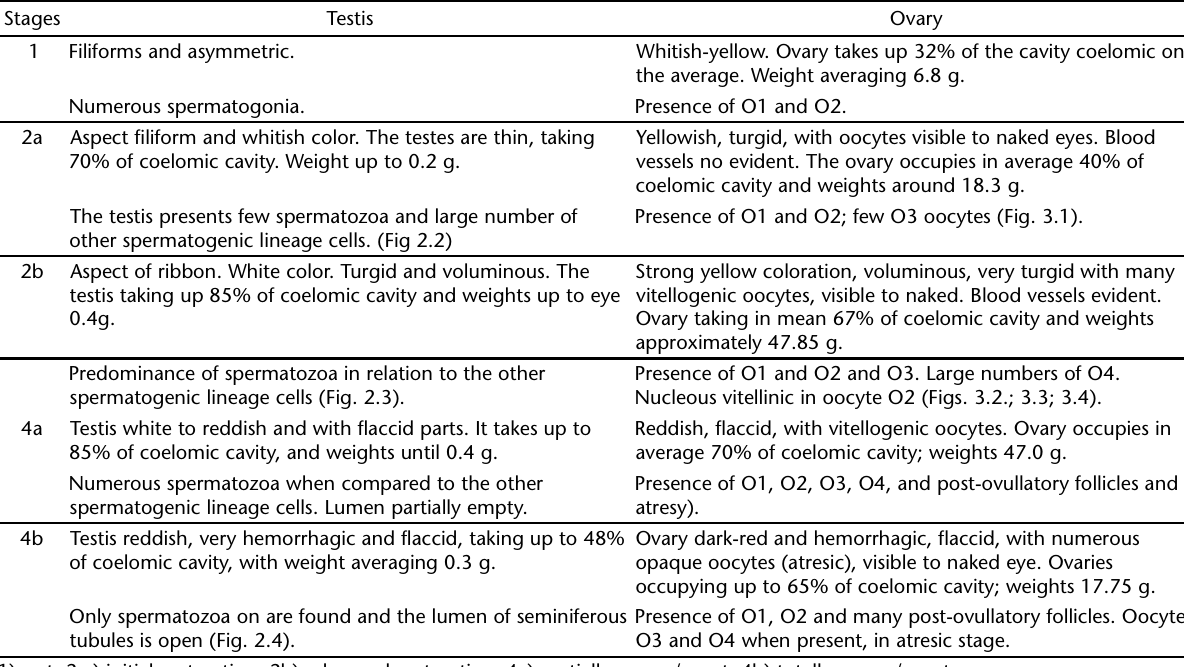
Table I. Macroscopic and histological description of gonads for males and females for Hypostomus affinis by maturity stages. Stages Testis Ovary 1 Filiforms and asymmetric.